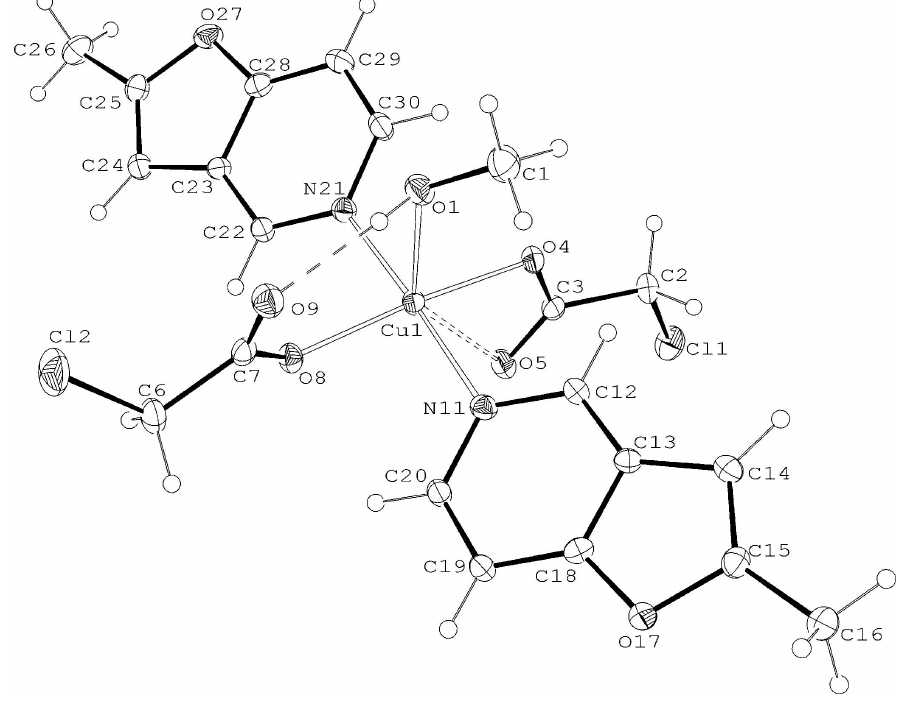
Perspective view of the title compound, with the atom numbering scheme and thermal ellipsoids drawn at the 30% probability